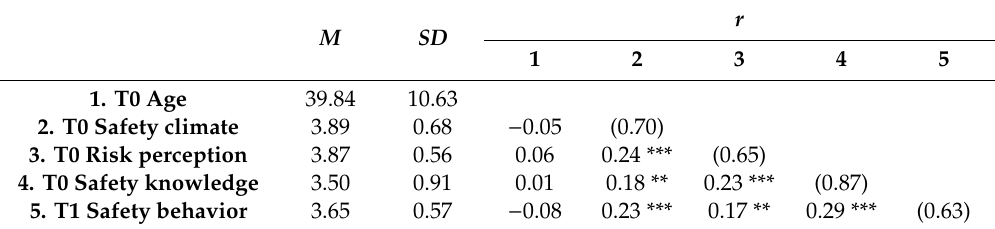
Table 1. Means, Standard deviation, Cronbach’s Alphas (in brackets), and Correlations among the study variables ( N =